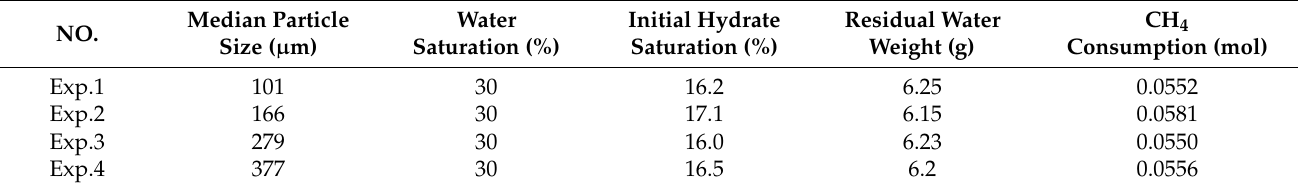
Table 2. Hydrate formation at different particle sizes .